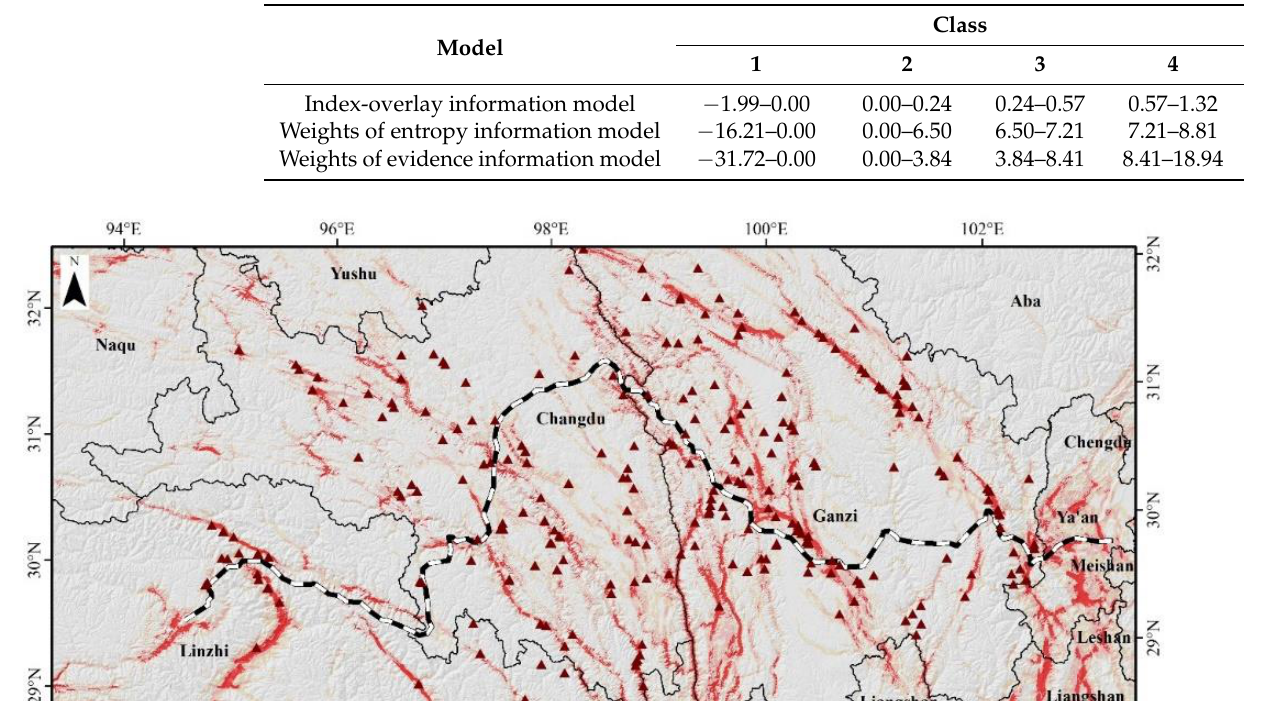
( c ) Weights of evidence information model Figure 7. Classification maps of prediction.